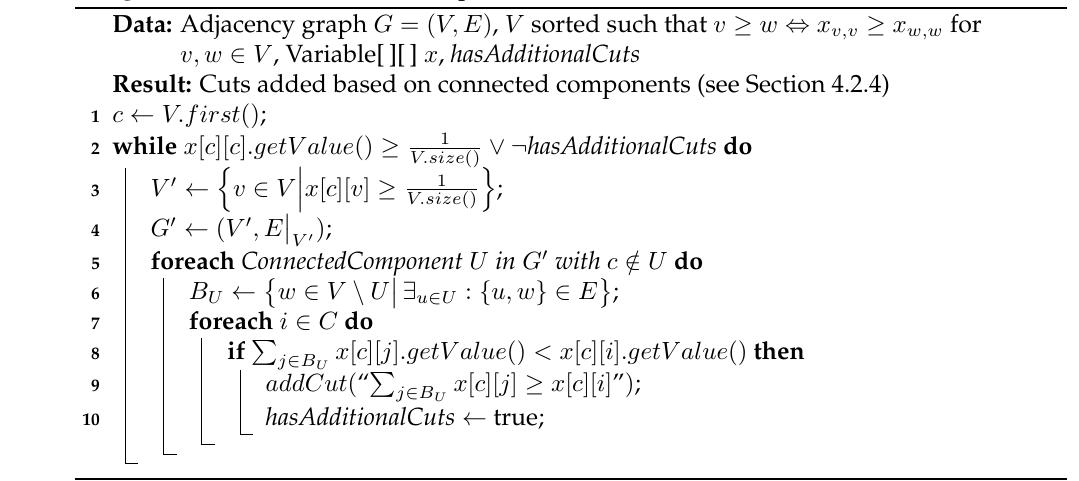
Algorithm 2: addConnectedComponentsCuts